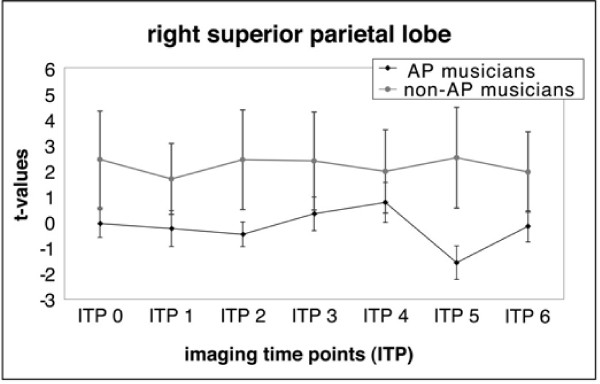
Time course of mean (SD) regional t-scores for the ROI in the right SPL/IPS (error bars represent the between subject variability).